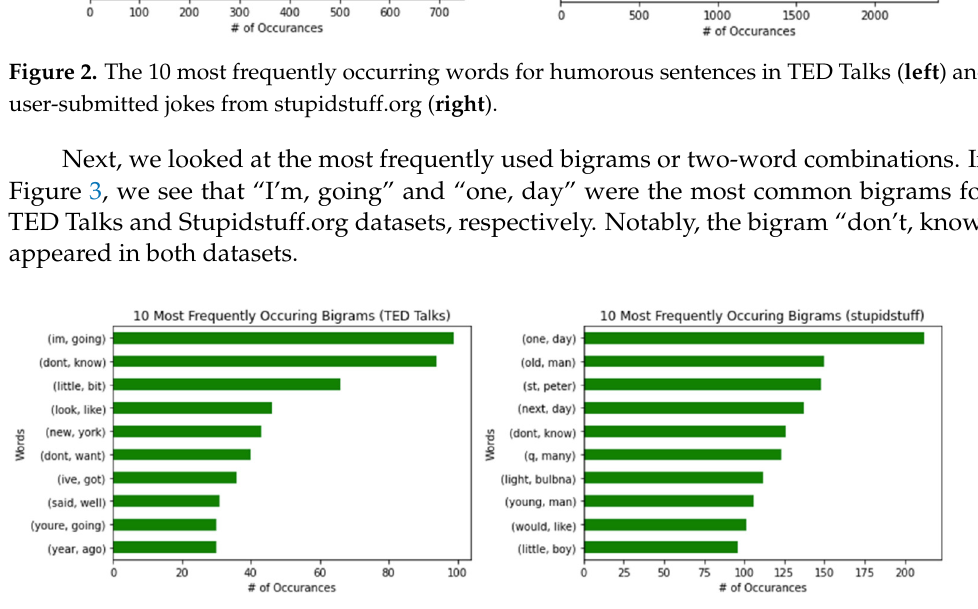
Figure 4. The 10 most frequently occurring trigrams for humorous sentences in TED Talks ( left ) and user-submitted jokes from stupidstuff.org ( right ). 3.2.2. Part of Speech (POS) We observed a high usage of possessive ending (POS) and proper nouns in singular form (NNP) for both datasets. This result supports previous works that state that humor- ous messages tend to use possessive forms and proper nouns [88–90]. Figure 5 below con- tains information on the two datasets’ top 10 most frequently used POS. Strikingly, the top 10 commonly used POS were similar for the two datasets. For example, the POS verbs in gerund or present participle form and verbs in the past tense form were frequently observed.